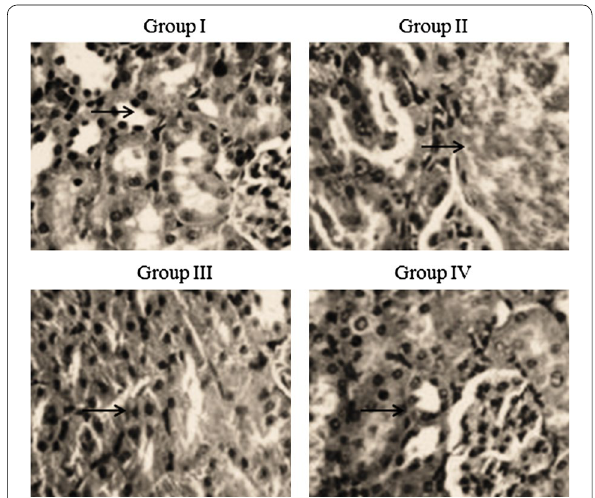
Fig. 4 Effect of atorvastatin and amygdalin on the cellular architecture of transplant salvage tissue of Sprague-Dawley rats with experimentally induced endometriosis. Magnification: